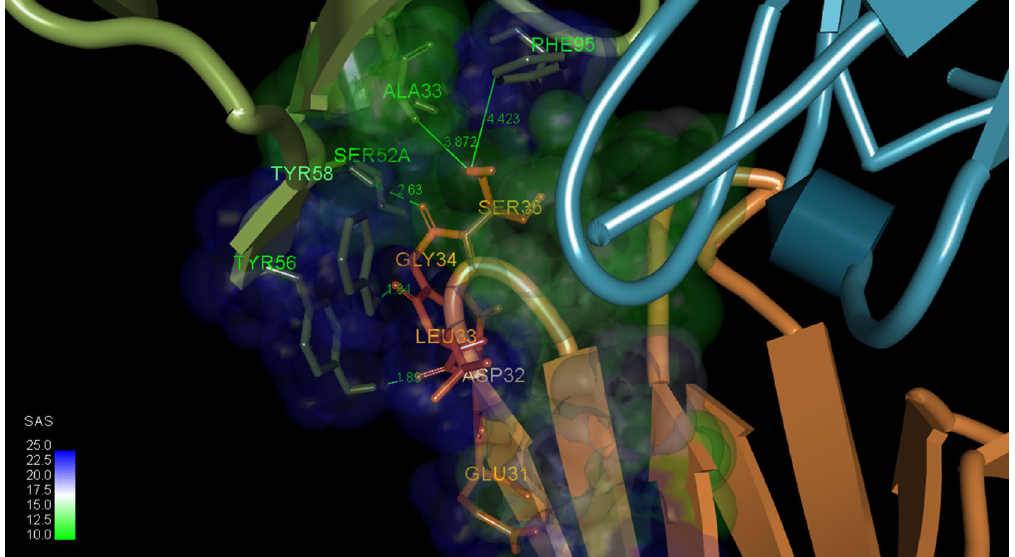
Figure 5. Atomic-level observation of amino acid residues participating in the HuScFvM61B9-CD147 predicted binding structure. Key residues on CDRs of HuScFvM61B9 and domain 1 of CD147 at the binding surface are highlighted in green and orange,